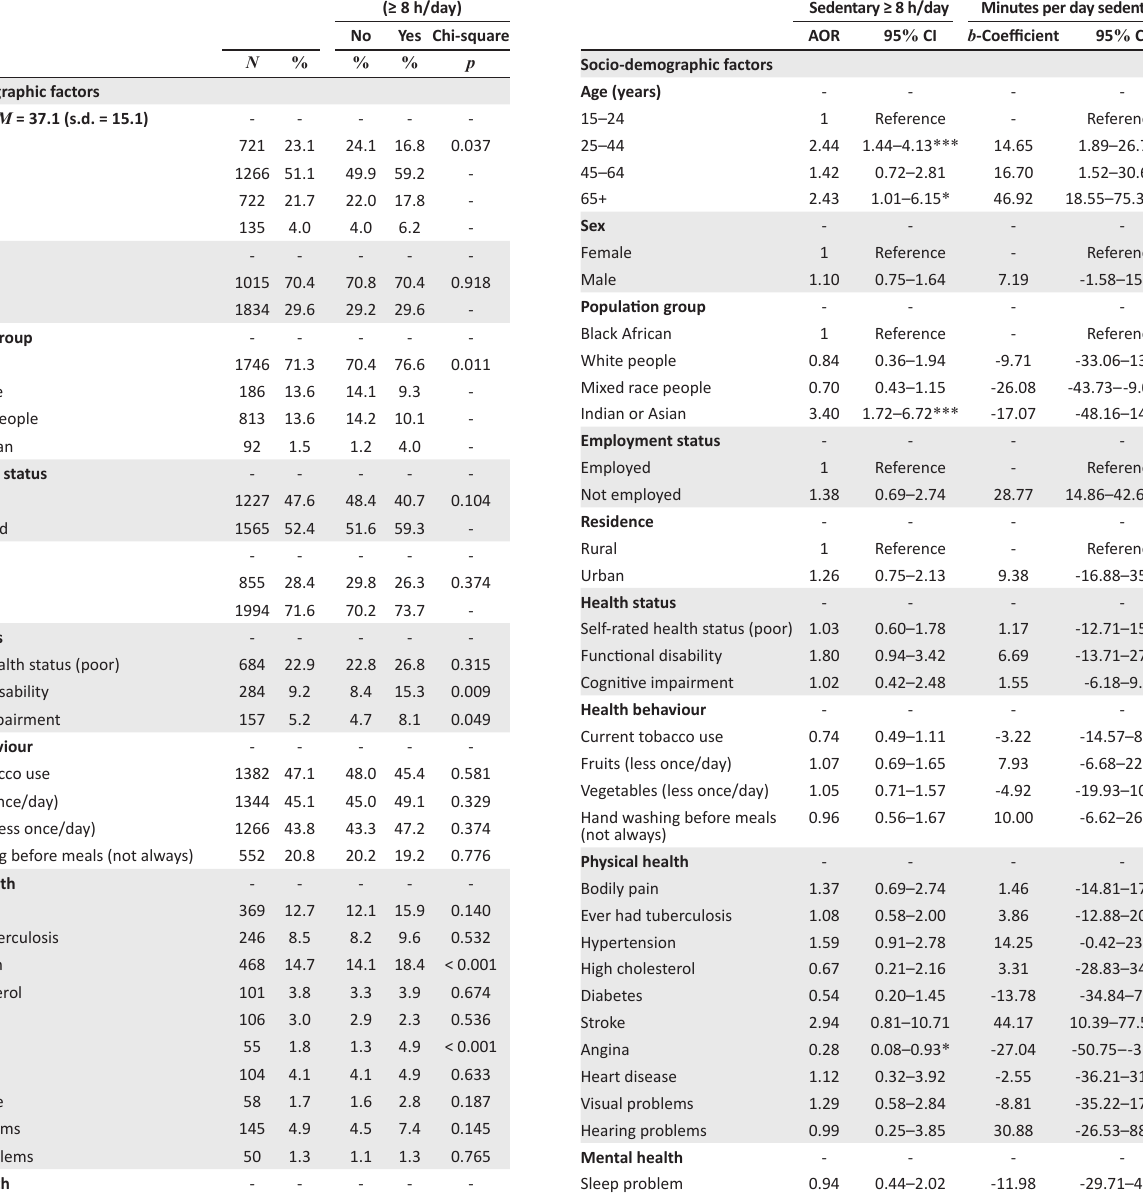
TABLE 2: Associations of socio-demographic and health variables with sedentary behaviour levels among problem drinkers. Variable Logistic regression: Linear regression: Sedentary ≥ 8 h/day M inutes per day